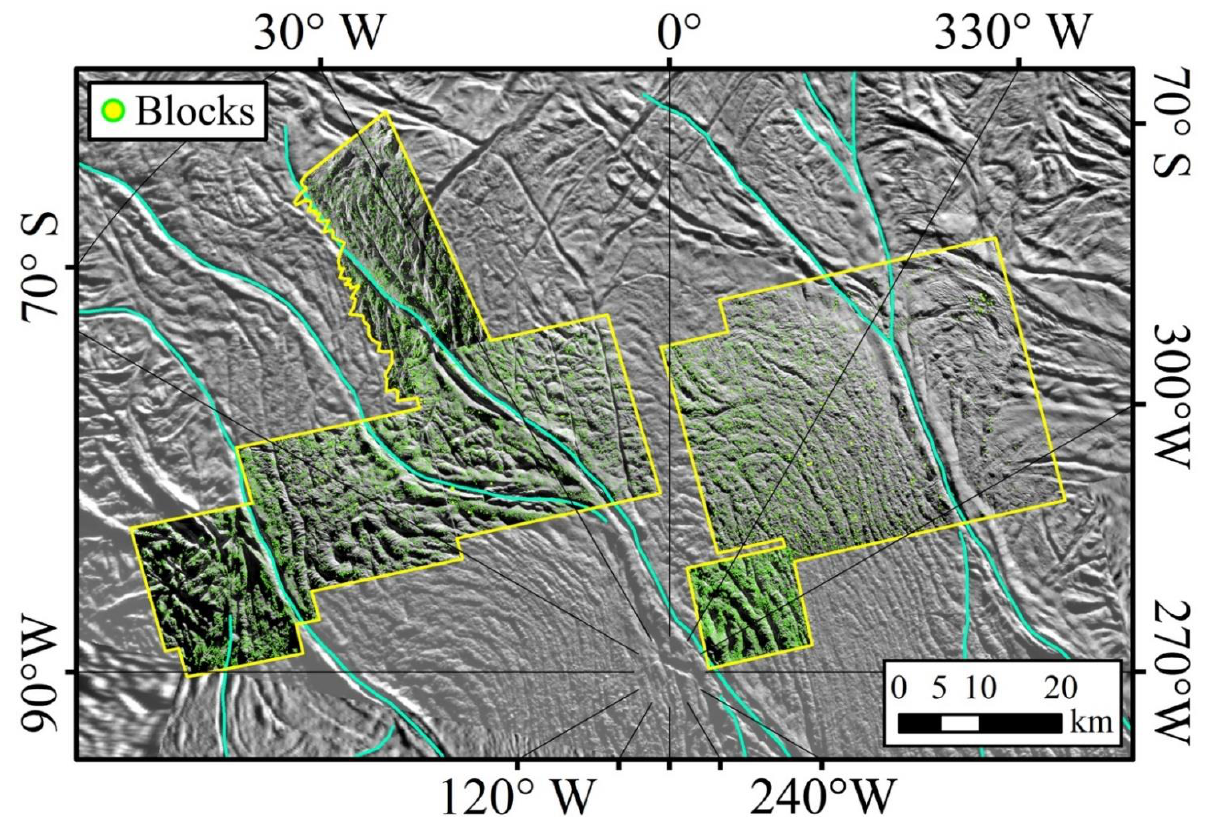
Figure 4. The 17,070 blocks identified in the SPT between Damascus, Baghdad and Cairo Sulci .